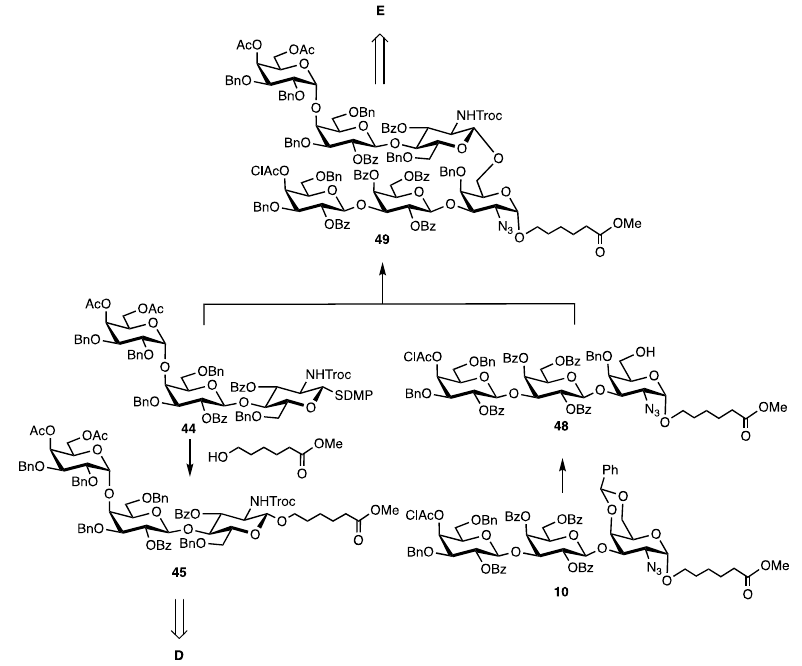
Figure 6. Synthetic strategy of tri- and hexasaccharides. Molecules 2021 , 26 , x FOR PEER